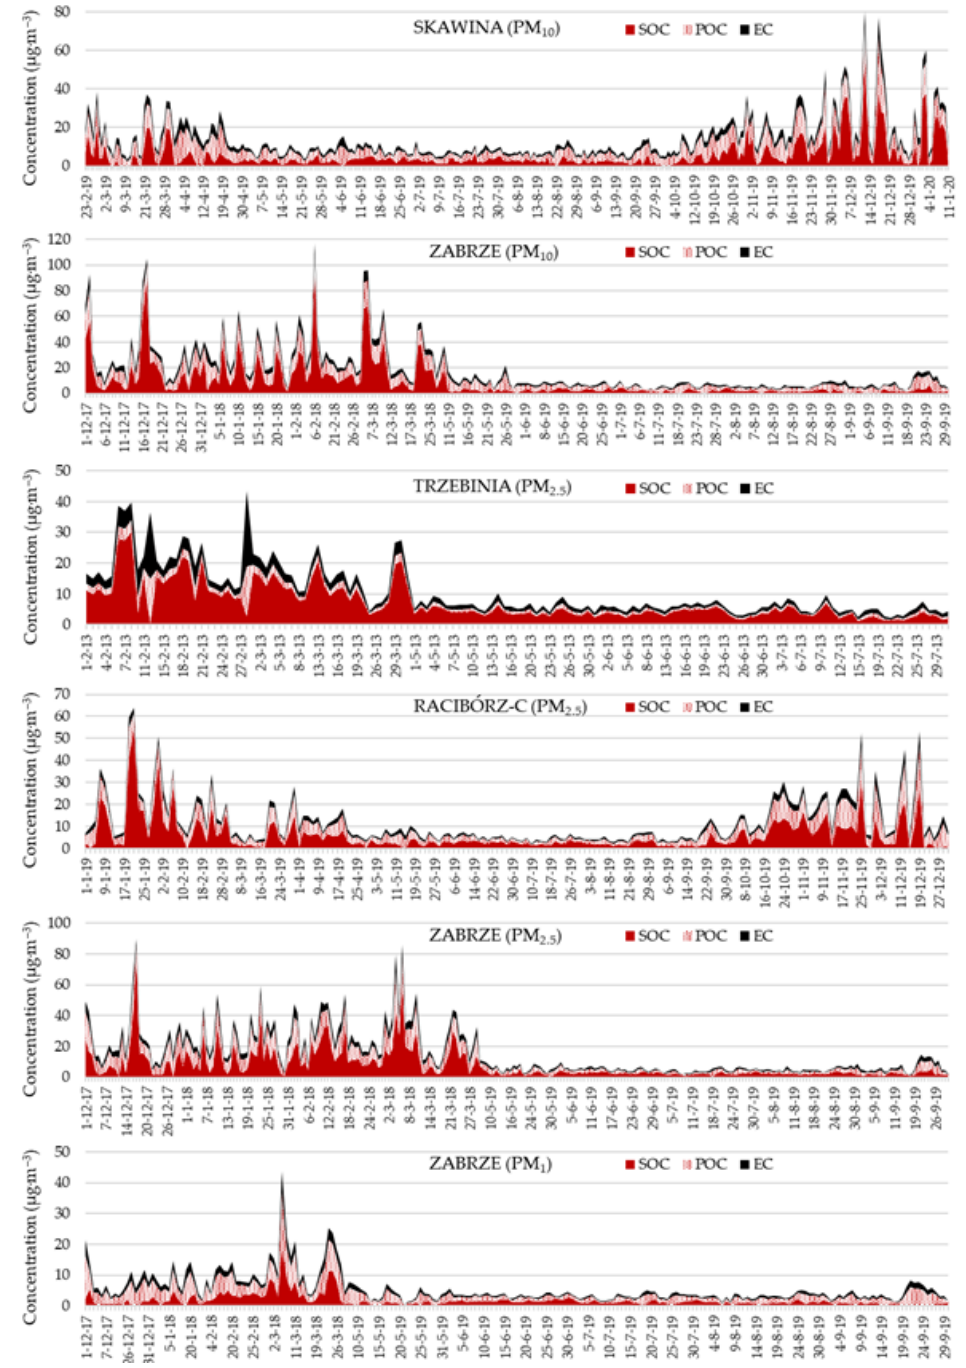
Figure 5. Time series of daily averaged concentrations of SOC, POC and EC (µg·m −3 ) at considered urban background sites.